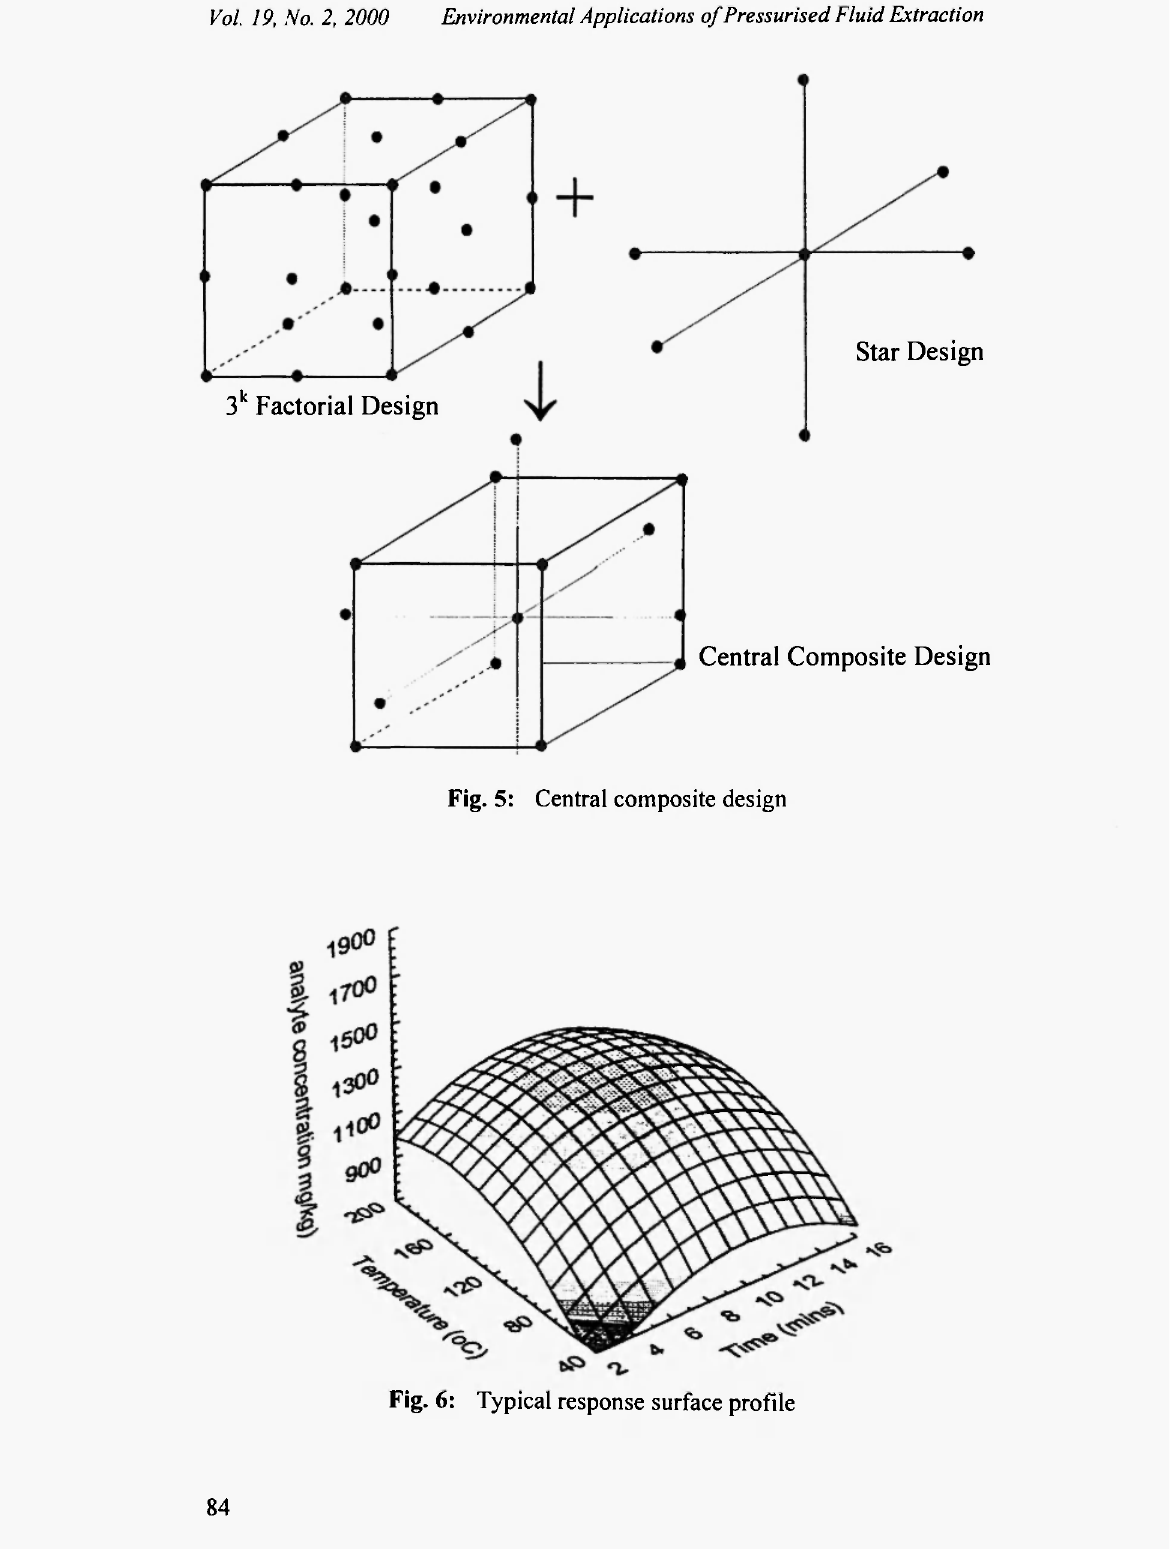
Fig. 6: Typical response surface